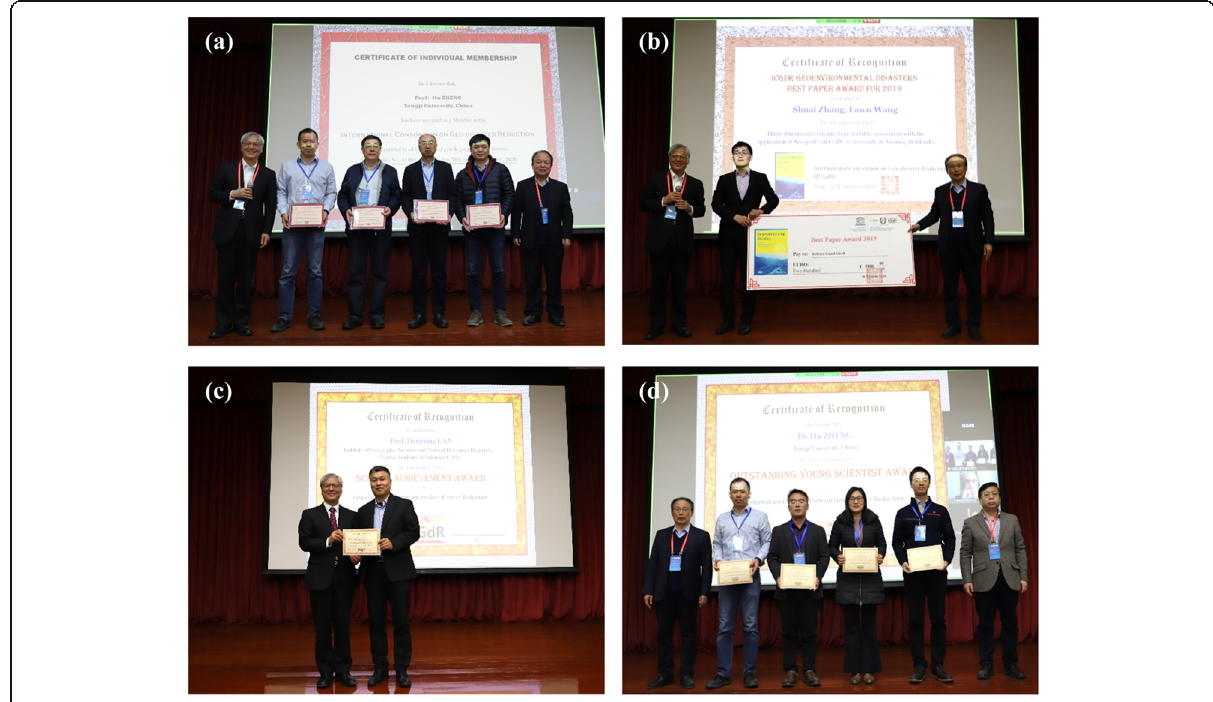
Fig. 3 Photos of the ICGdR Awards winners (Offline only): ( a) new ICGdR memberships, ( b) ICGdR Geoenvironmental Disaster Best Paper Award for 2019, ( c) Science Achievement Award and ( d) Outstanding Young Scientist Award